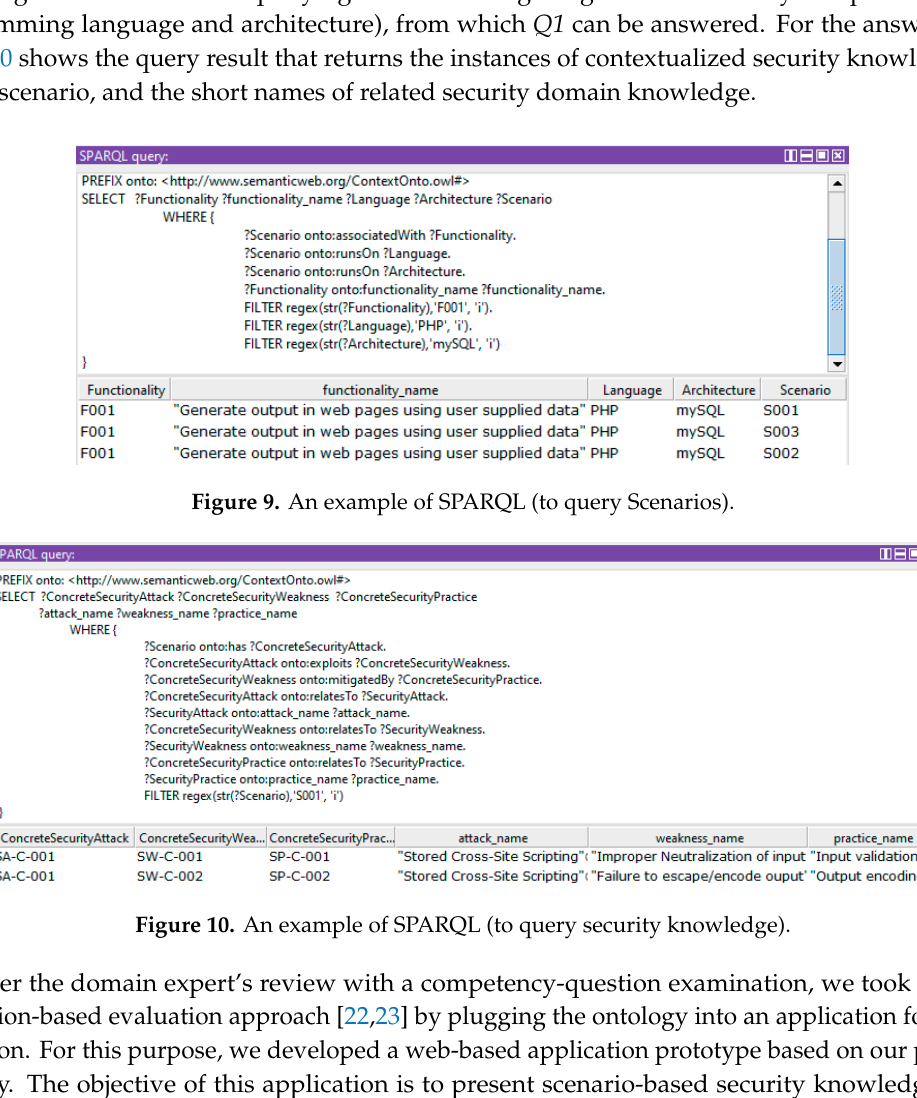
Figure 8. The objective property and data property of concrete knowledge (Security Attack).